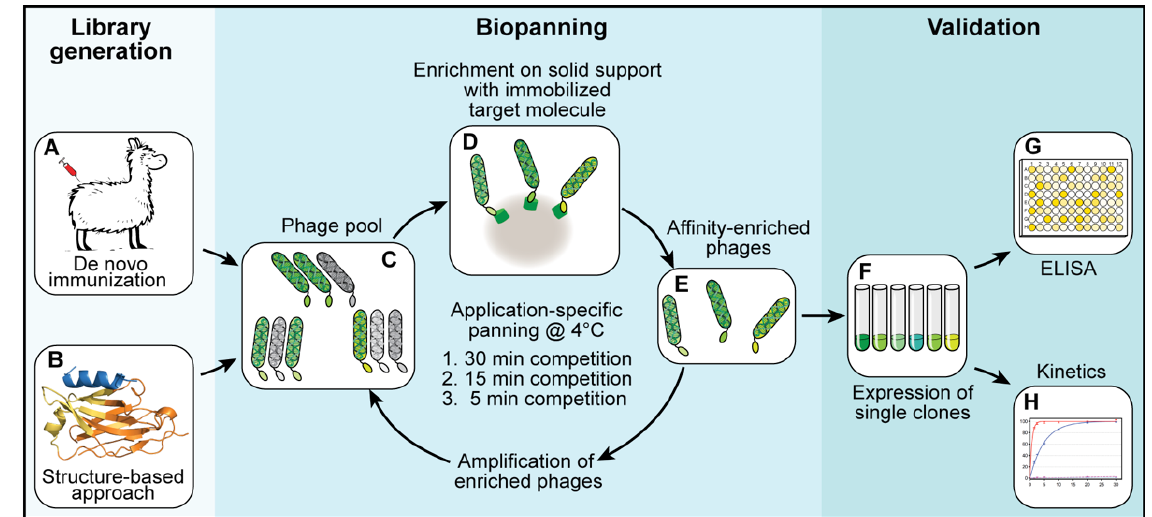
Figure 1. Schematic depiction of the workflow followed to create cold ‐ elutable ALFA binders. Two separate sdAb libraries were generated by either de novo immunization of alpacas ( A ) or a structure-guided approach based on the known structure of NbALFA in complex with the ALFA peptide ( B ). The resulting phage pools were separately used as input material for phage displays ( C – E ). In three rounds of biopanning, the selection stringency was increased by reducing both the amount of immobilized target protein and the time allowed for competitive elution at 4 ◦ C. Eluted phages were amplified and used as input for the next round of biopanning. After three rounds of biopanning, enriched NbALFA CE candidates were subcloned and expressed in E. coli ( F ). Candidates were further assayed by ELISA for their binding and elution properties ( G ) or subjected to a kinetic characterization ( H ).